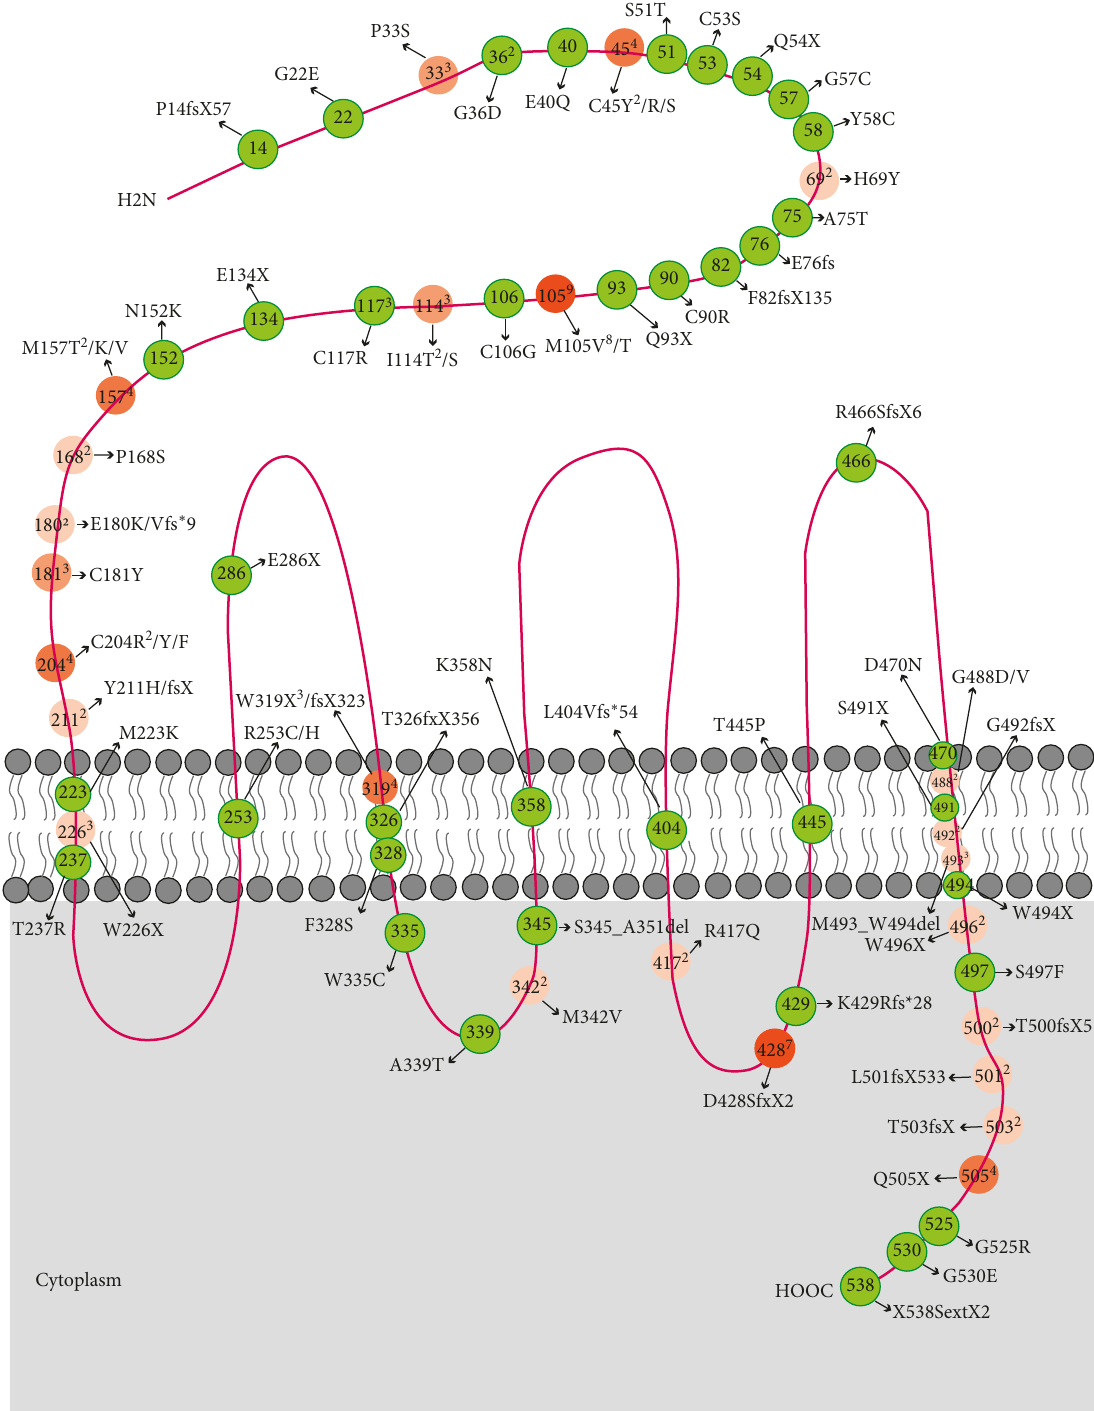
Figure 3: Schematic diagram of the Frizzled-4 protein shows the locations of the mutations. A whole gene deletion and a deletion/insertion (c.40 del/inser) with unknown protein change are not shown. Superscript number means the reported times of the same or different mutations at a certain site. The color of the mutations which were reported more than one time was recolored as orange. The opacity varied with the reported frequency of the